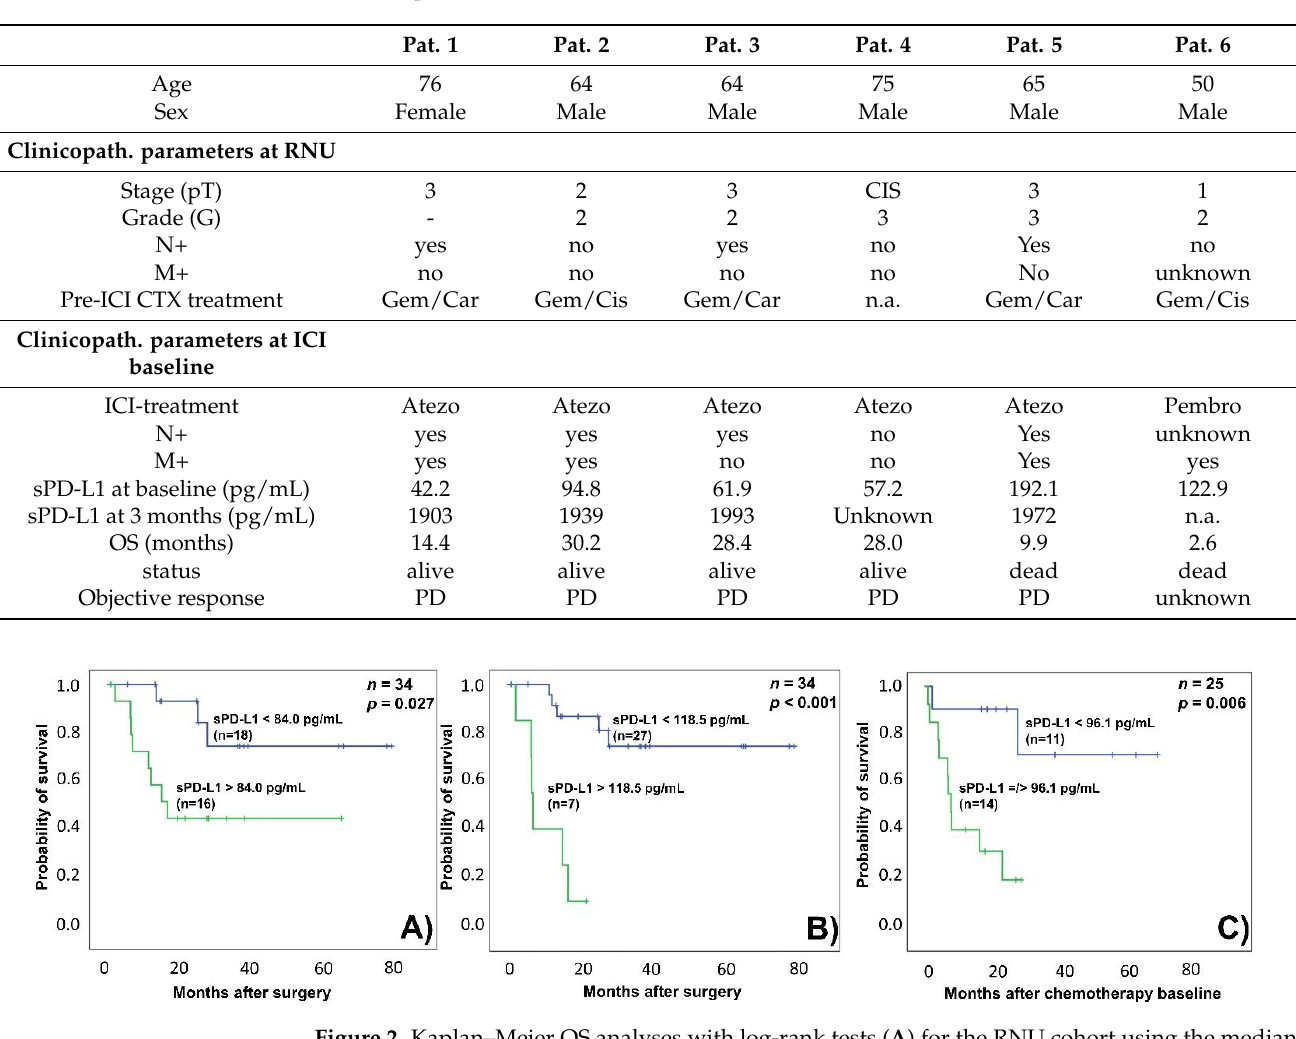
Table 2. Characteristics of ICI-treated patients. ICI—immune checkpoint inhibitor ther-